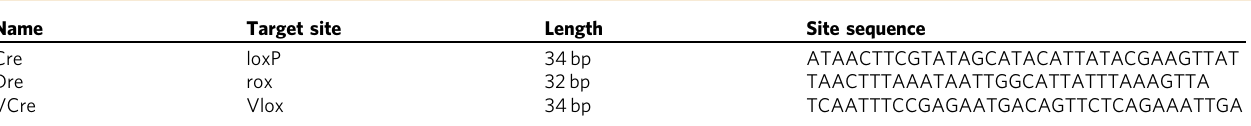
Table 1 Recombinase and target sites